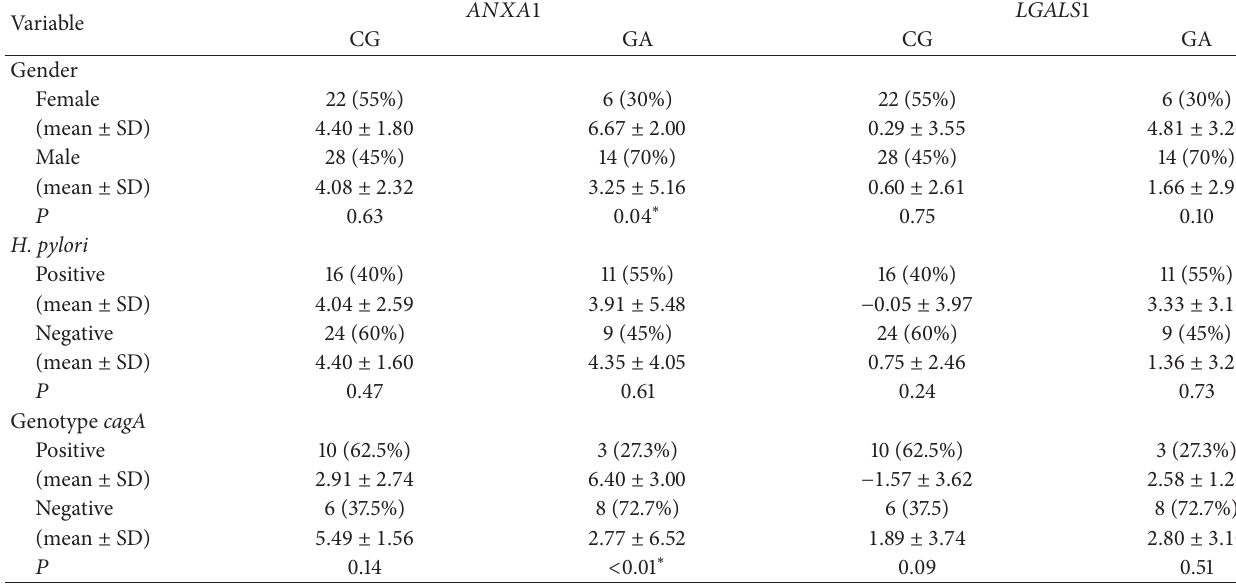
Table 5: Relative expression of ANXA1 and LGALS1 mRNA in chronic gastritis (CG) and gastric adenocarcinoma (GA) groups according to gender, infection by H. pylori , and presence of cagA +